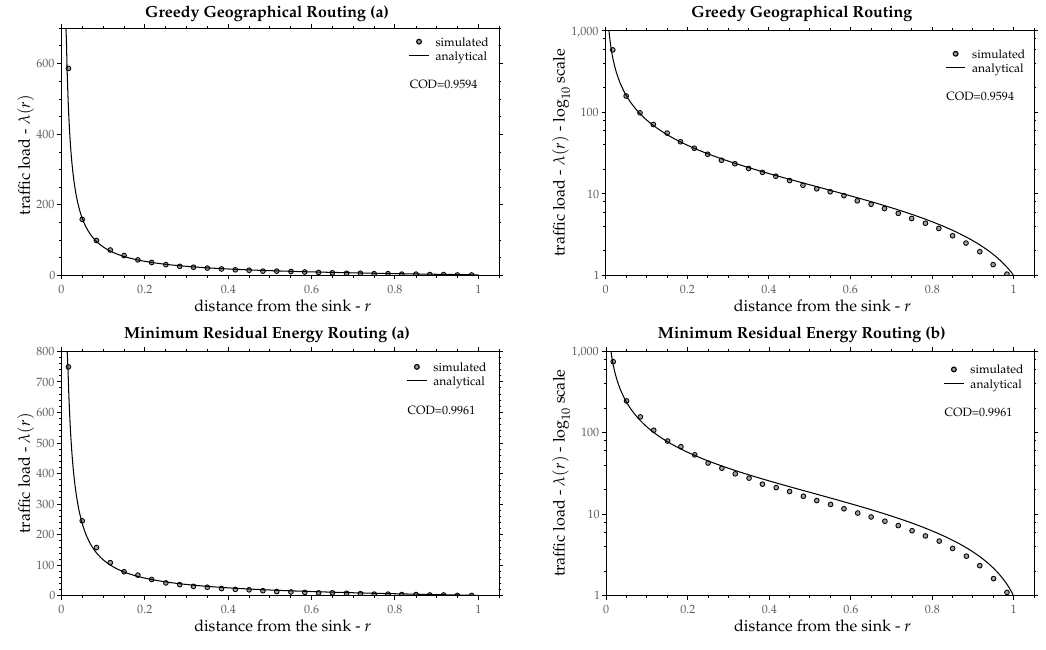
Figure 14. Comparison between Equation (25) and the simulated traffic load as a function of the distance from the sink, for two routing schemes, Greedy Geographical and Minimum Residual Energy. ( a ) normal (linear) plot, ( b ) semi-log plot